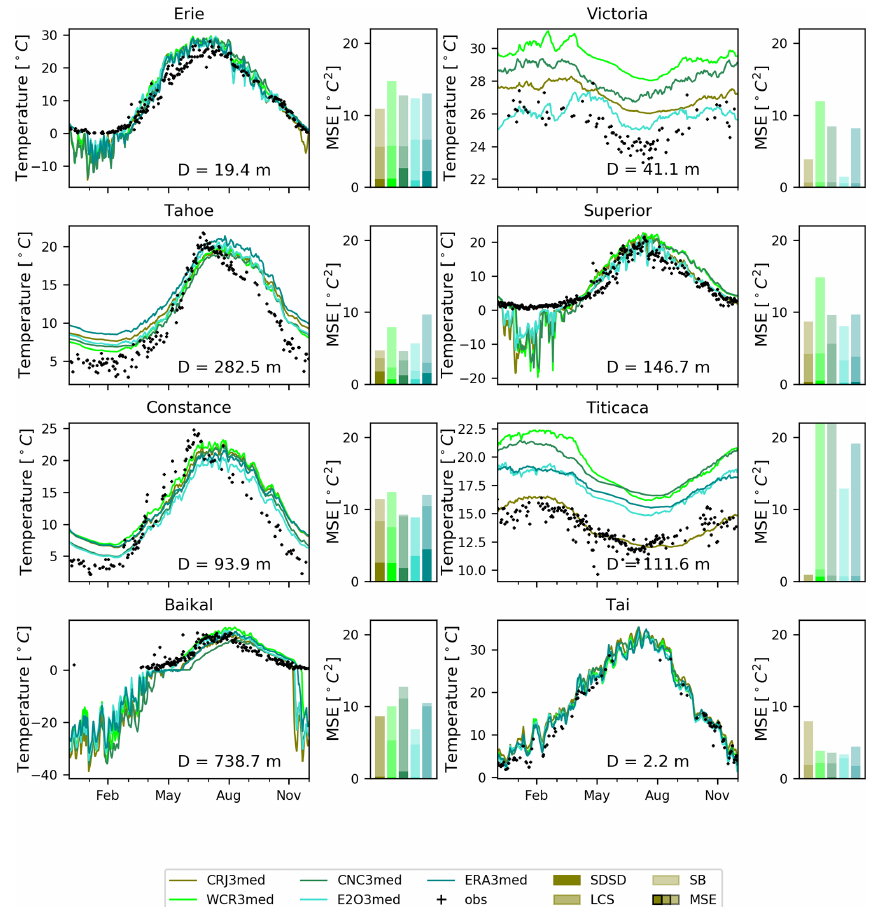
Figure 4. Example of time series of the daily mean lake surface temperature simulated for eight lakes with five different meteorological forcings compared to GloboLakes observations for the year 2010. The bar plots represent the decomposition of the MSEs in terms of bias (SB), lack of correlation (LCS) and difference of standard deviations (SDSD) (represented with different shadings) between the model and the observations.